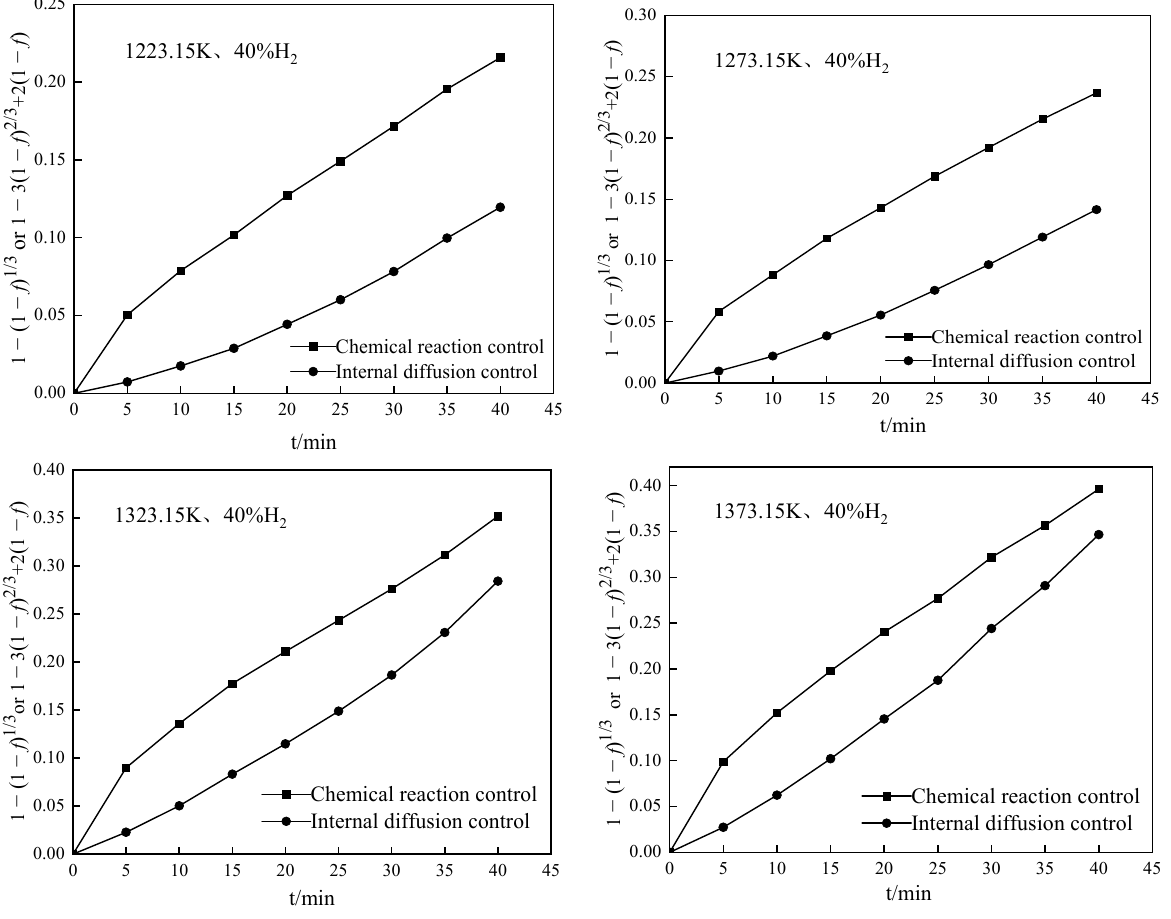
Figure 10. Comparison curve of the chemical-controlled reduction with the diffusion-controlled reduction.